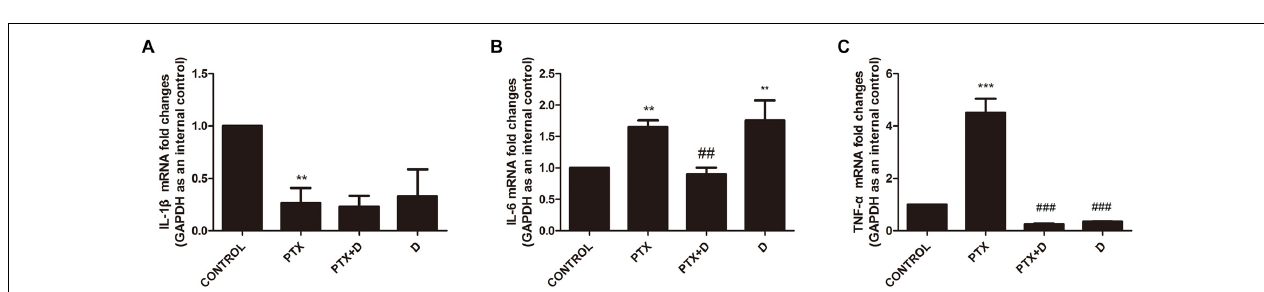
FIGURE 11 | Transcript levels of the proinflammatory cytokines IL-1 β , IL-6 and TNF- α in the mouse DRG. Total mRNA was extracted from mouse DRG tissues. qPCR was performed and a comparison is shown between different groups after saline or 28 days of drug treatment. (A) IL-1 β expression was significantly decreased after PTX treatment, but duloxetine did not alter this decrease. (B) Duloxetine significantly decreased the expression of IL-6 mRNA in the DRG of PTX-treated mice. (C) Duloxetine significantly decreased the expression of TNF- α mRNA in the DRG of PTX-treated mice. ( ∗∗ p < 0.01, ∗∗∗ p < 0.001 vs. control; ## p < 0.01, ### p < 0.001 vs. PTX). The data are presented as the mean ± SEM ( n =